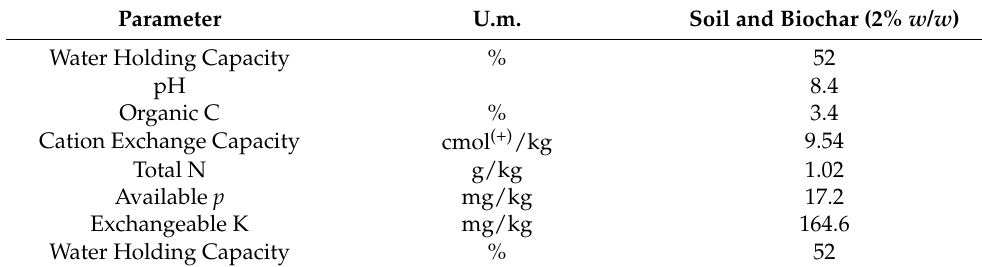
Table 2. Soil characteristics after amendment with biochar.